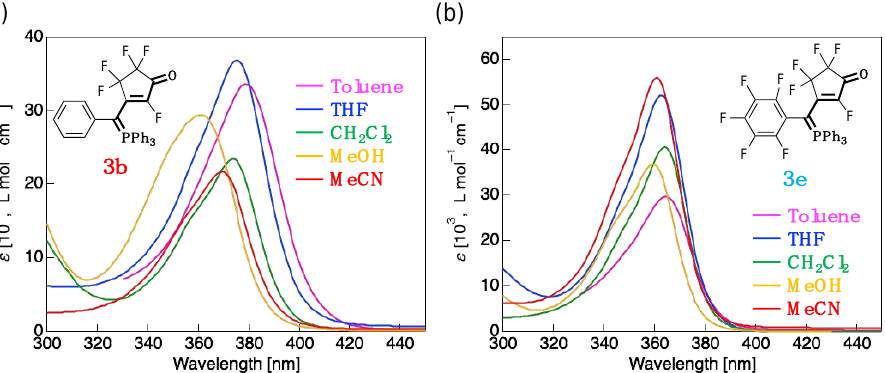
Figure 6. UV-vis absorption spectra measured in various solvents for: ( a ) 3b (R = phenyl; C 6 H 5 ); ( b ) 3e (R = pentafluorophenyl, C 6 F 5 ).